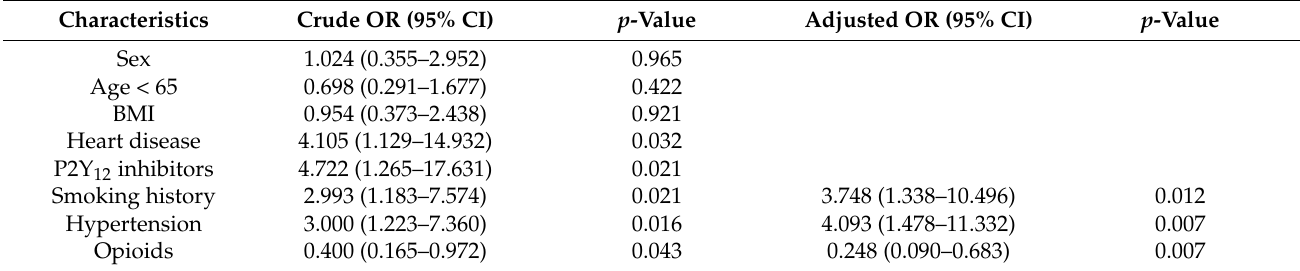
Table 2. Multivariable analysis to identify predictors for thyroid-related adverse events in patients receiving immune checkpoint